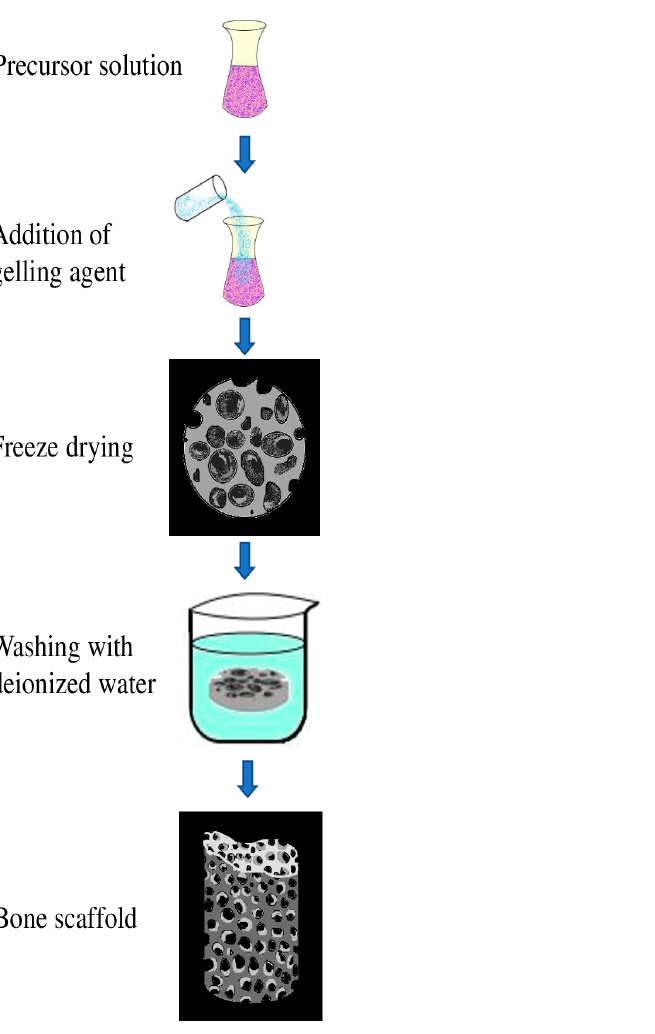
Figure 9. Process of fabricating a bone scaffold using PHA nanocomposite by employing lyophi ‐ lization.